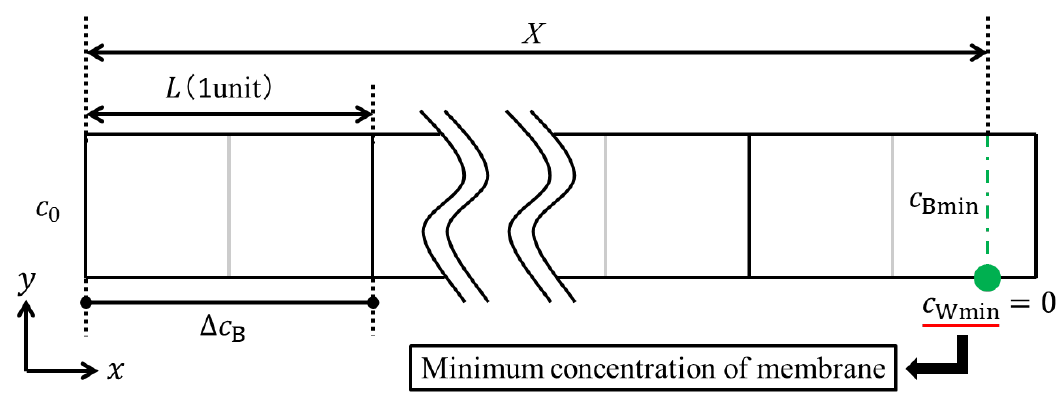
Figure 2. Limiting current density occurrence point. A point where water dissociation is occurring is located at the end of a channel in the dilute phase. c Bmin and c Wmin are indicated as the minimum bulk concentration and the minimum concentration on the membrane, respectively. Furthermore, c 0 and X are the initial concentration and length of the dilute channel, which are given from experimental condition.